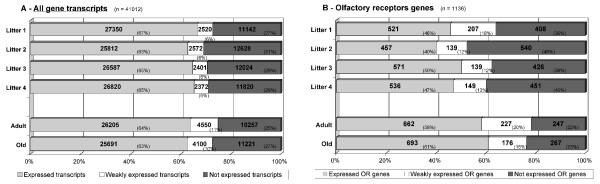
Expression of gene transcripts and OR transcripts at various ages. Grouping of gene transcripts and OR transcripts into three categories: expressed, weakly expressed and non expressed. In experiments describing adult olfactory epithelium mRNA profiles (Figure 1), total transcripts and OR genes were identified as being expressed when ~75% of the samples gave a corresponding hybridization signal above background levels. Similarly in the experiments described in this figure, we selected as threshold 3 in the case of each litter, 6 for the adults and 6 for the old rats. "Not expressed" total transcripts and "not expressed" OR genes did not show positive signal (above background) for any of the samples.